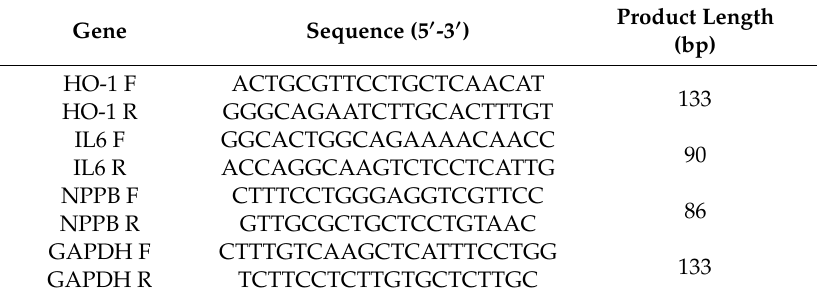
Table 1. Primer sequences used for RT-PCR analysis.